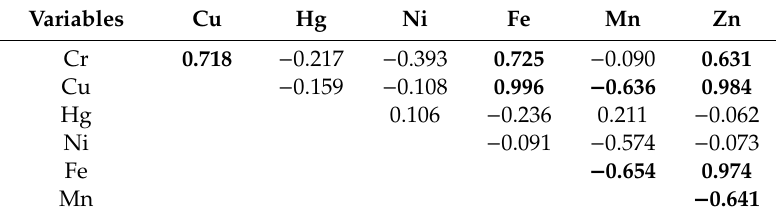
Table 4. Minerals and toxic metals found in the baby foods and infant formulae.